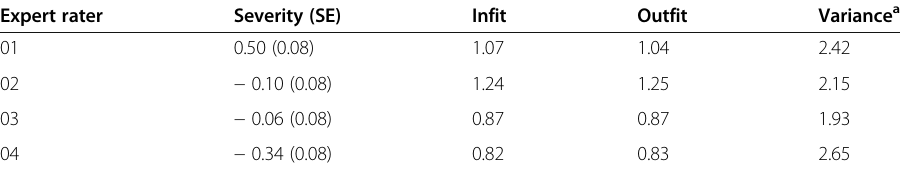
Table 5 Rater fit statistics of expert raters Expert rater